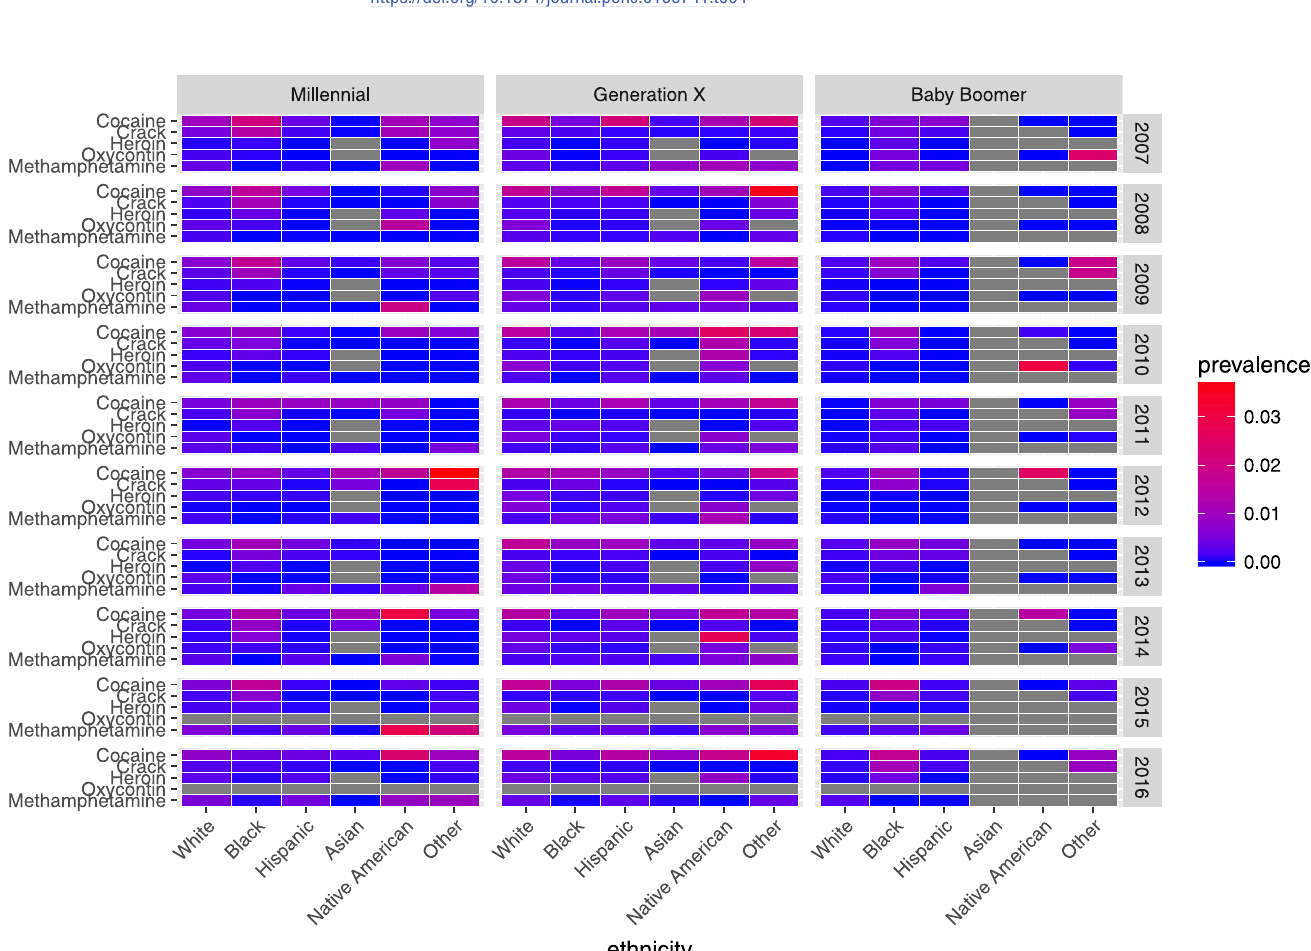
PLOS ONE | https://doi.org/10.1371/journal.pone.0199741 June 25,